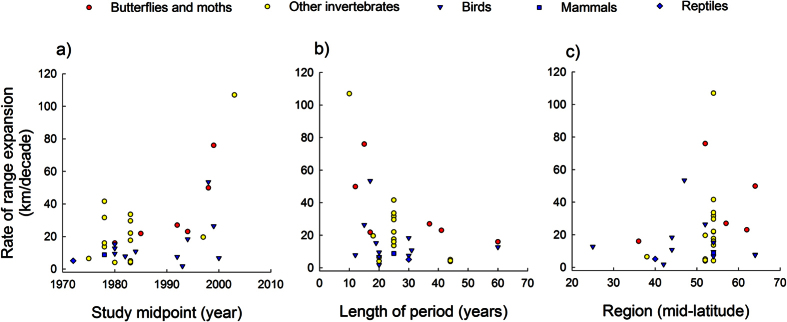
Rates of range boundary expansions vary among groups of terrestrial animals and change over time and with latitude.Rates of boundary shifts for butterflies and moths (N = 7 studies), invertebrates other than butterflies and moths (N = 14), reptiles (N = 1), birds (N = 11), and mammals (N = 1) were obtained from previous studies (see Supplementary Table S4). Results from statistical evaluation of associations are reported in Table 2.